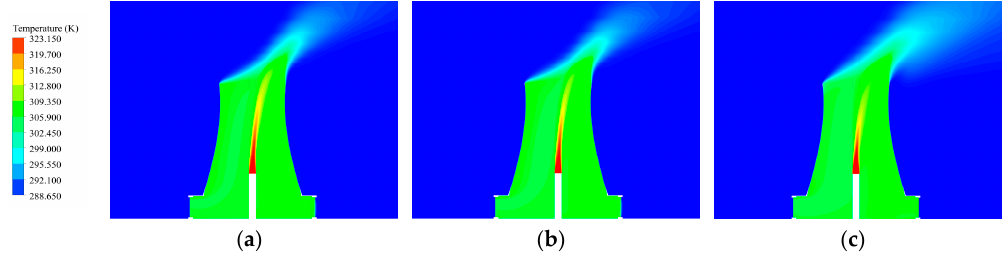
Figure 10. Comparisons of temperature distribution at vertical plane (y = 0 m) in NDDCT with flue gas injection: ( a ) RANS; ( b ) URANS; ( c ) LES.